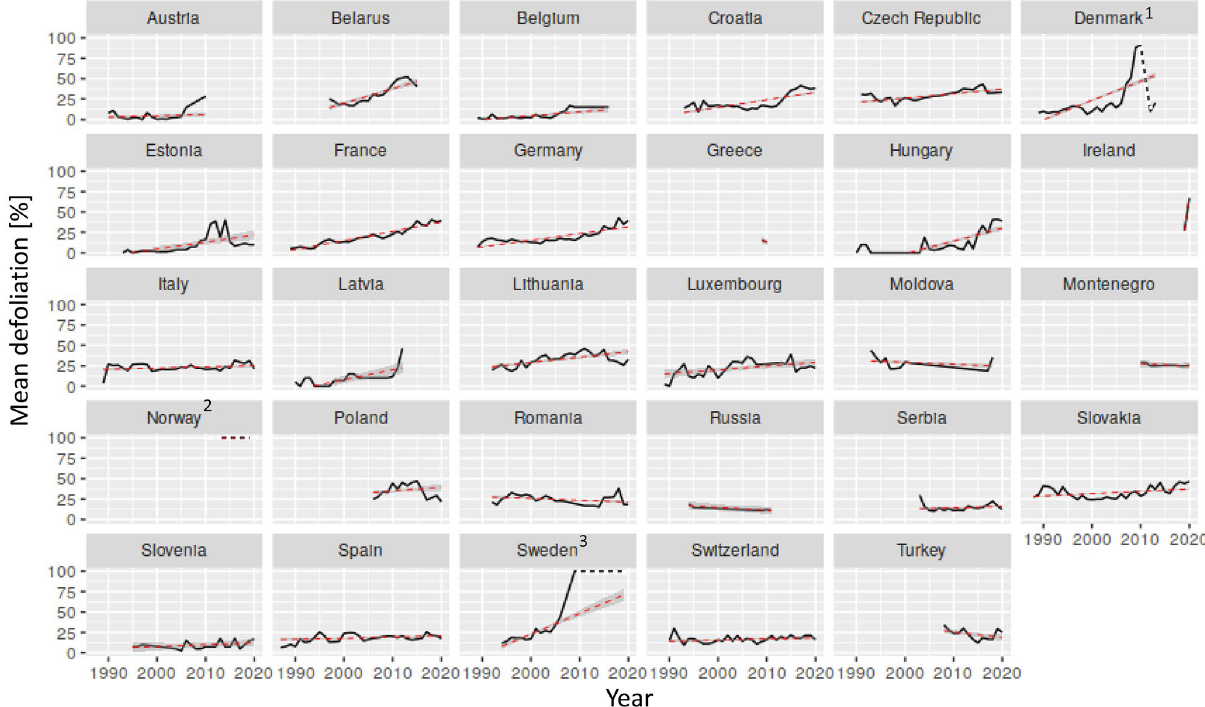
Figure 3. Mean defoliation across plots by survey country. Red dashed line shows linear time-series trend. 1 Note that the downward trend in Denmark is caused by lost of of some plots and does not show